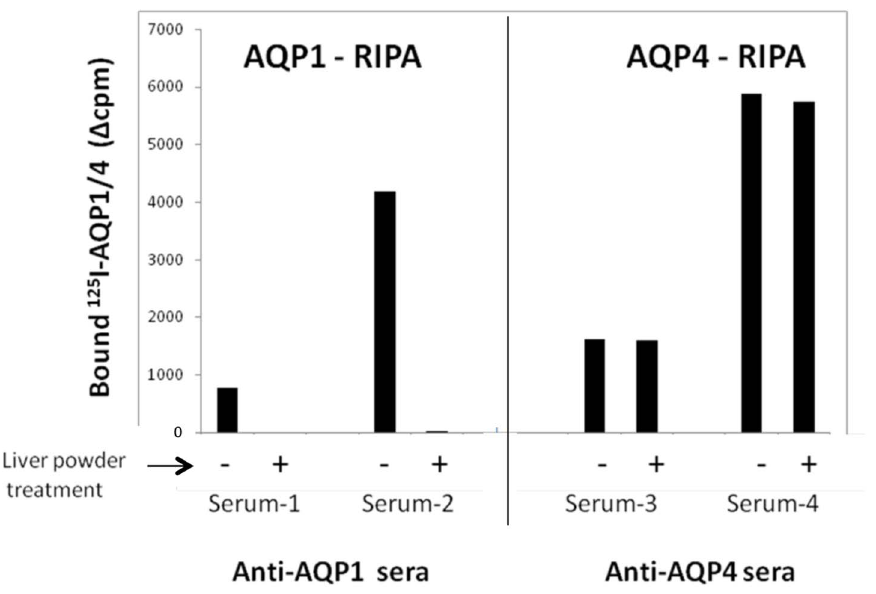
Figure 2. Liver powder removes anti-AQP1 antibodies . Two exclusively anti-AQP1-positive and two exclusively anti-AQP4-positive serum samples were pretreated with guinea pig liver powder, then the supernatants were tested by RIPA using indirectly radiolabeled AQP1 (left panel) or AQP4 (right panel). Key: + , pretreated serum; -, untreated serum.